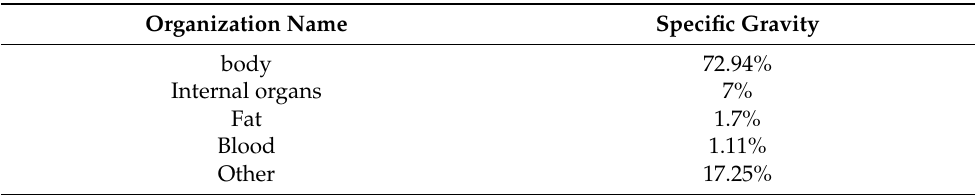
Table 5. Values of specific gravity of